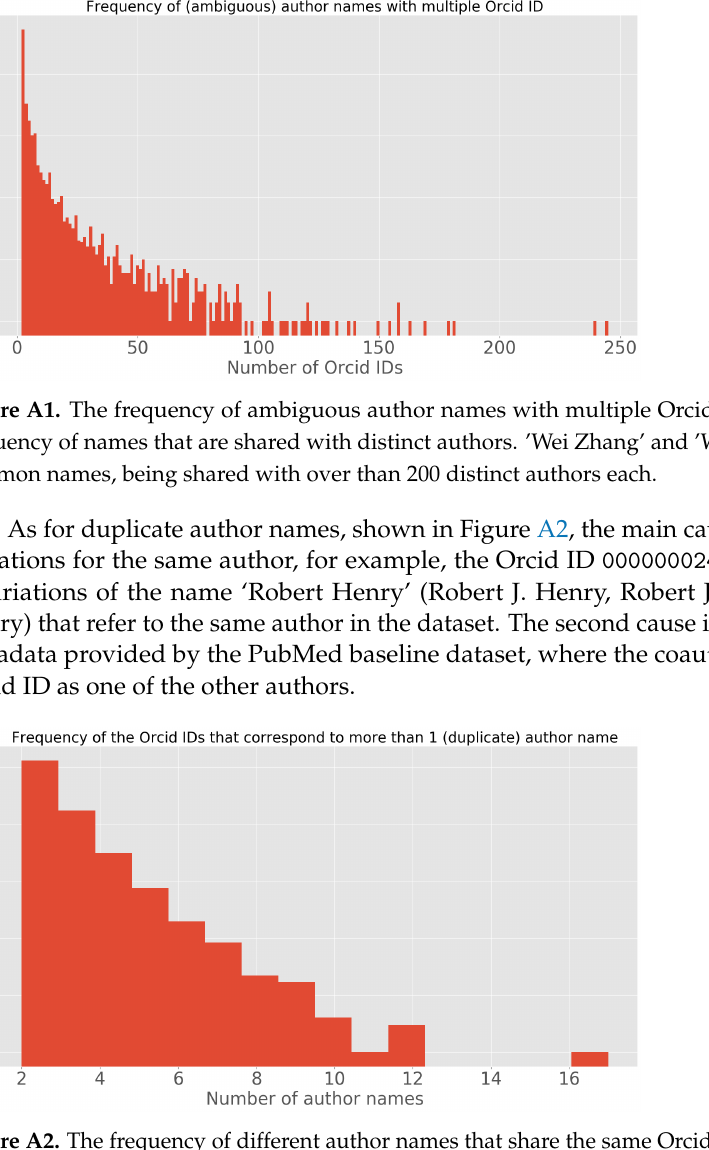
Figure A2. The frequency of different author names that share the same Orcid ID. It represents Orcid IDs that are present in more than 1 author name entry, due to author name